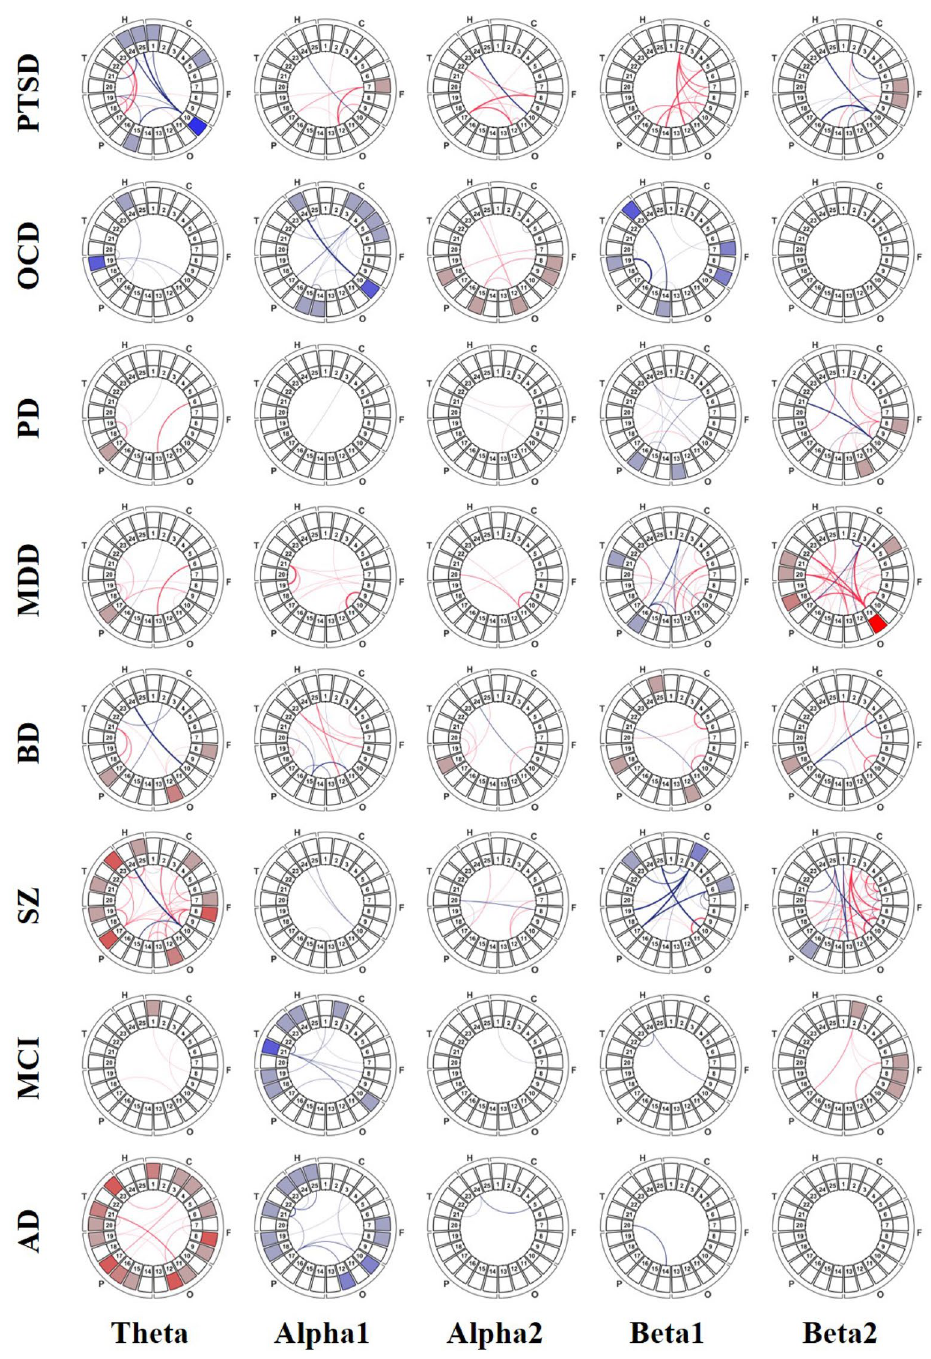
compulsive disorder, PD panic disorder, MDD major depressive disorder, BD bipolar disorder, SZ schizophrenia, MCI mild cognitive impairment, AD Alzheimer’s